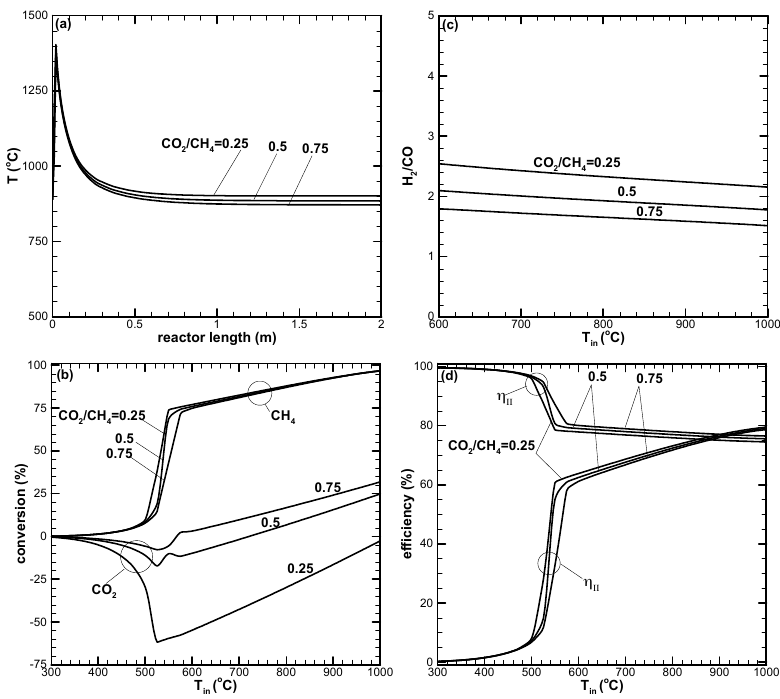
Figure 9. Effect of CO 2 /CH 4 ratios on the TR process. CO 2 /CH 4 is varied from 0.25 to 0.75 while the other parameters were kept unchanged, as listed in Table 1. ( a ) Temperature variation along reactor with T in = 900 ◦ C; ( b ) CH 4 and CO 2 conversions; ( c ) H 2 /CO ratio; and ( d ) first- and second-law